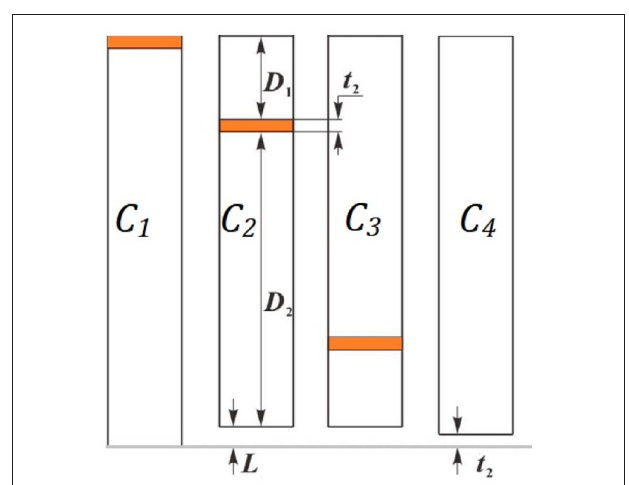
FIGURE 4 | The equivalent simplified four